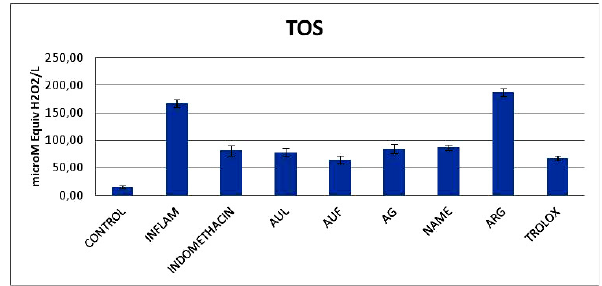
Fig. 1. Serum total oxidant